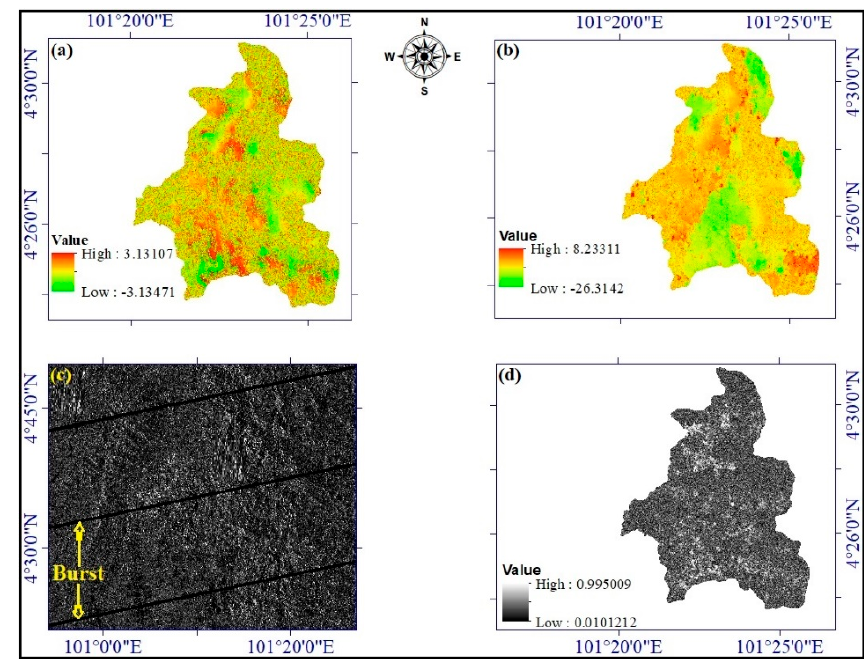
Figure 5. The processing of SAR images to create an interferogram output; ( a ) phase band, ( b ) unwrapped band, ( c ) bursts in Sentinel-1 imagery and ( d ) coherence